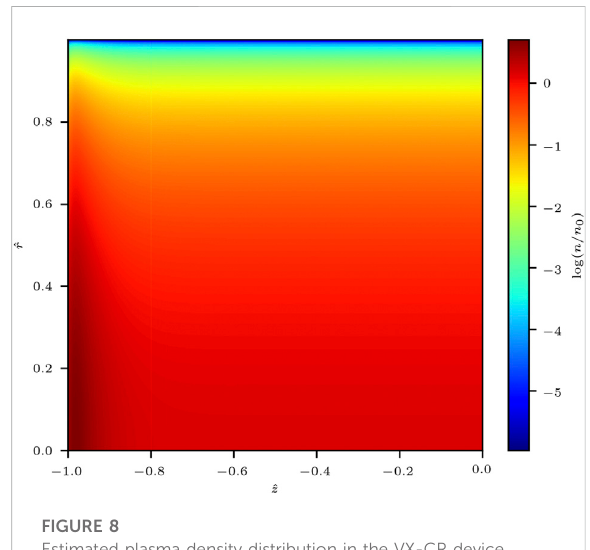
FIGURE 8 Estimated plasma density distribution in the VX-CR device [22, 28], as estimated by Ahedo ’ s model [12, 20]. The relevant geometrical and physical parameters used for this simulation